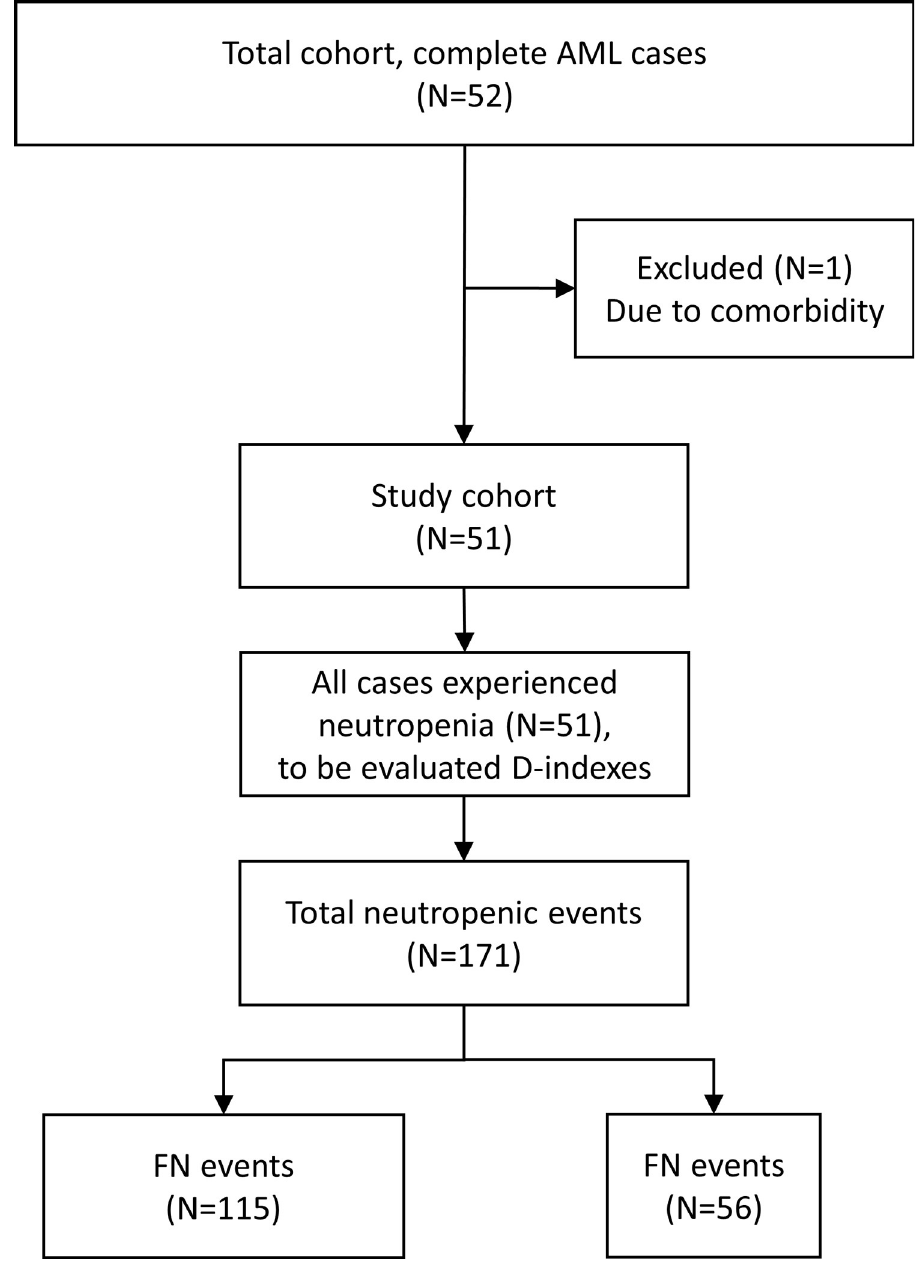
Fig 2. Study patients flow chart. We gathered 51 patients treated for acute myeloid leukemia at our institute. In total, 171 neutropenic events, of which 115 febrile neutropenia episodes were comorbid, were used in our study.